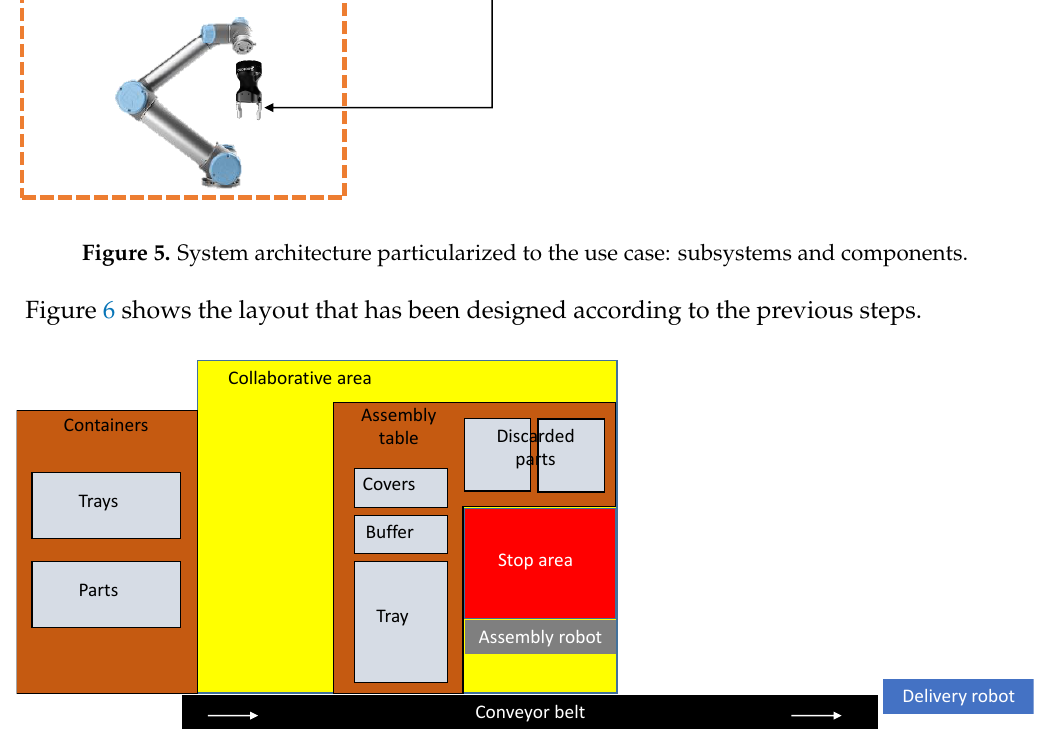
Figure 6. Layout for the physical location of the use case